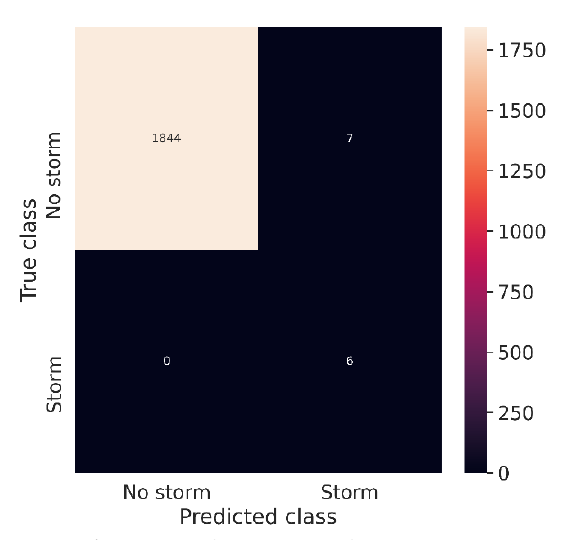
Figure 6 . Confusion matrix of the SVM model.